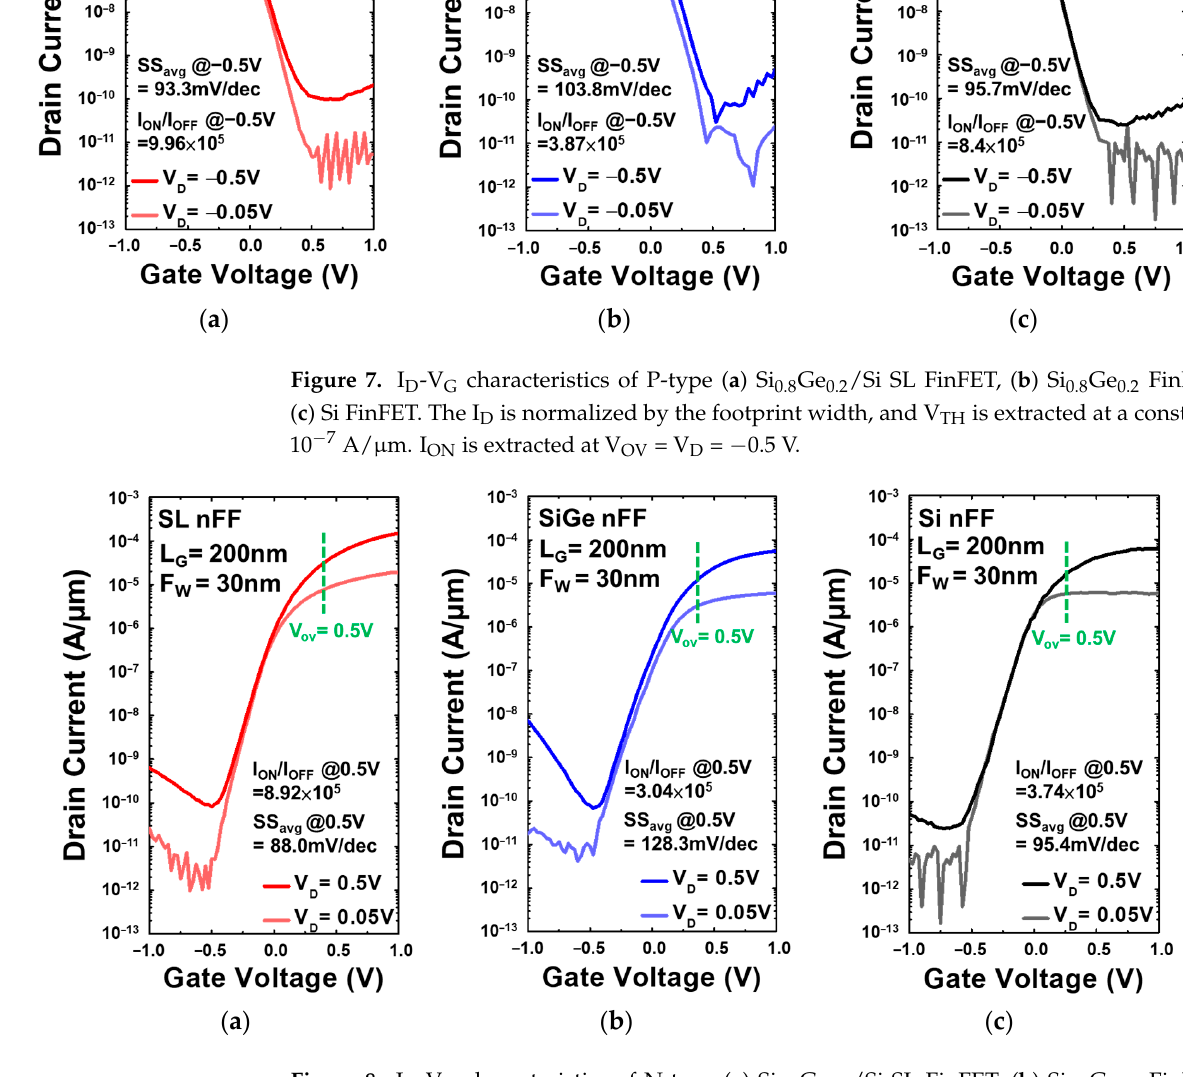
Figure 8. I D -V G characteristics of N-type ( a ) Si 0.8 Ge 0.2 /Si SL FinFET, ( b ) Si 0.8 Ge 0.2 FinFET, and ( c ) Si FinFET. The I D is normalized by the footprint width, and V TH is extracted at a constant I D of 10 − 7 A/µm. I ON is extracted at V OV = V D = 0.5 V. Figure 9a shows that the Si 0.8 Ge 0.2 /Si SL FinFET has a drive current (V OV = V D = ± 0.5 V) of 124.6 µ A/ µ m, which is 141.8% and 55.6% higher than that of the Si FinFET and Si 0.8 Ge 0.2 FinFET, respectively, for the P-type. In Figure 9b, the drive current for the Si 0.8 Ge 0.2 /Si SL FinFET is 92.5 µ A/ µ m, which is 52.7% and 61.1% higher than that of the Si FinFET and Si 0.8 Ge 0.2 FinFET, respectively, for the N-type. Figure 10a,b show that the Si 0.8 Ge 0.2 SL FinFETs exhibit the highest maximum transconductance (G m,P ) of 375.2 µ S/ µ m and G m,N 235.1 µ S/ µ m at V D = ±